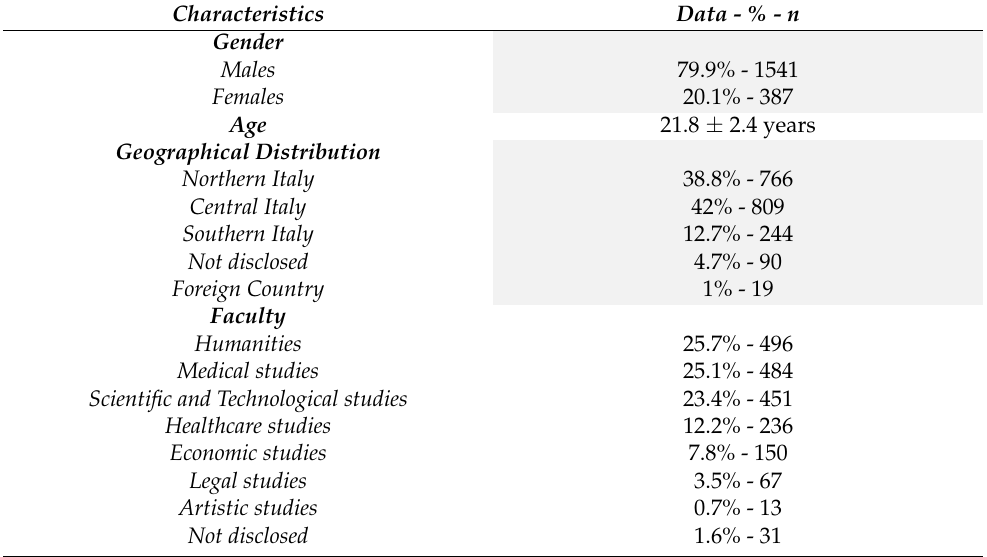
Table 3. Characteristics of study population: Gender, Age, Location and Faculties. Humanities (Letters, Philosophy, DAMS, Tourism, Languages, Scenography, Communication, Training, Goods cultural, Political Science, Sociology, Anthropology), Medical studies (Medicine and Dentistry); Scien- tific and Technological Studies (Engineering, Graphics, Architecture, Chemistry for Pharmaceutical Technologies, Physics, Agriculture, Design, Geology, Mathematics, Biology, Biotechnology, Veterinary, Chemistry, Pharmacy, Statistics, Optics, Oenology, Sciences Motor, Aviation); Healthcare studies (Nursing, Physiotherapy, Psychology, Obstetrics, Dental Hygiene, Radiology, Neuropsychomotric- ity, and Rehabilitation); Economic studies (Economy, Marketing, management, Banking Sciences, Finance); Legal studies (Law and Legal Services); Artistic studies (Academy of Fine Arts, Multimedia Arts, and Conservatory). Characteristics Data - % -